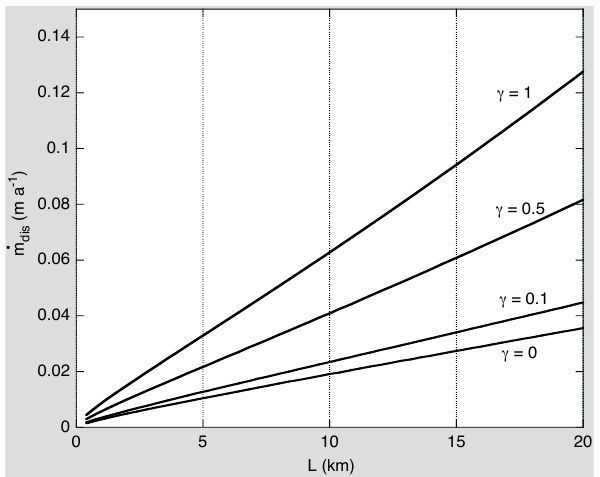
Fig. 3. Mean dissipative melting, averaged over the glacier, as a function of glacier length for different values of the precipitation gradient (labels inma − 1 km − 1 ) . Parameter values: b 0 = 2000m, p 0 = 1000ma − 1 , s = 0 . 1.